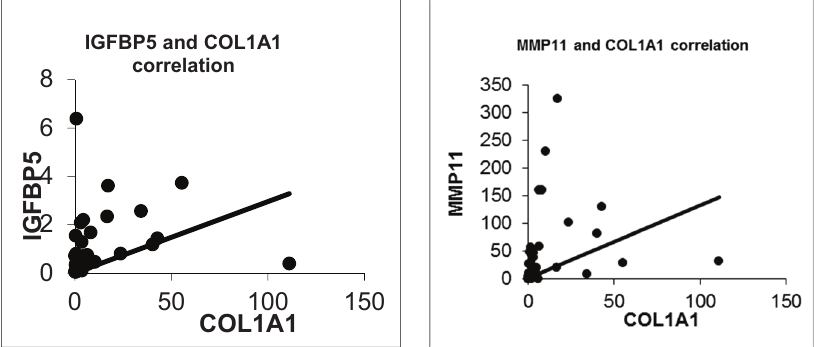
Figure 3. Scatter plots of the selected genes in real time